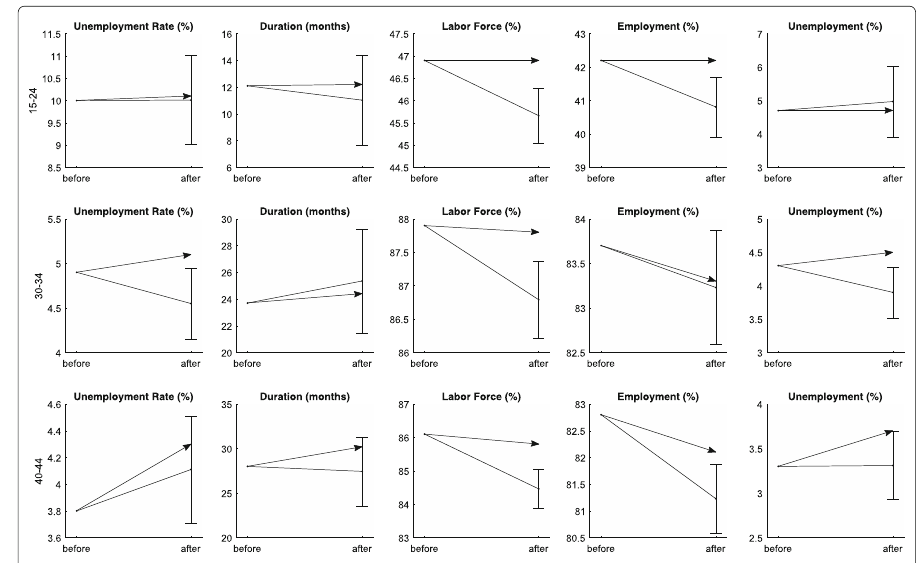
Fig. 1 Data and predictions. Arrows : model predictions, γ = 8. Lines : data and confidence intervals with two standard